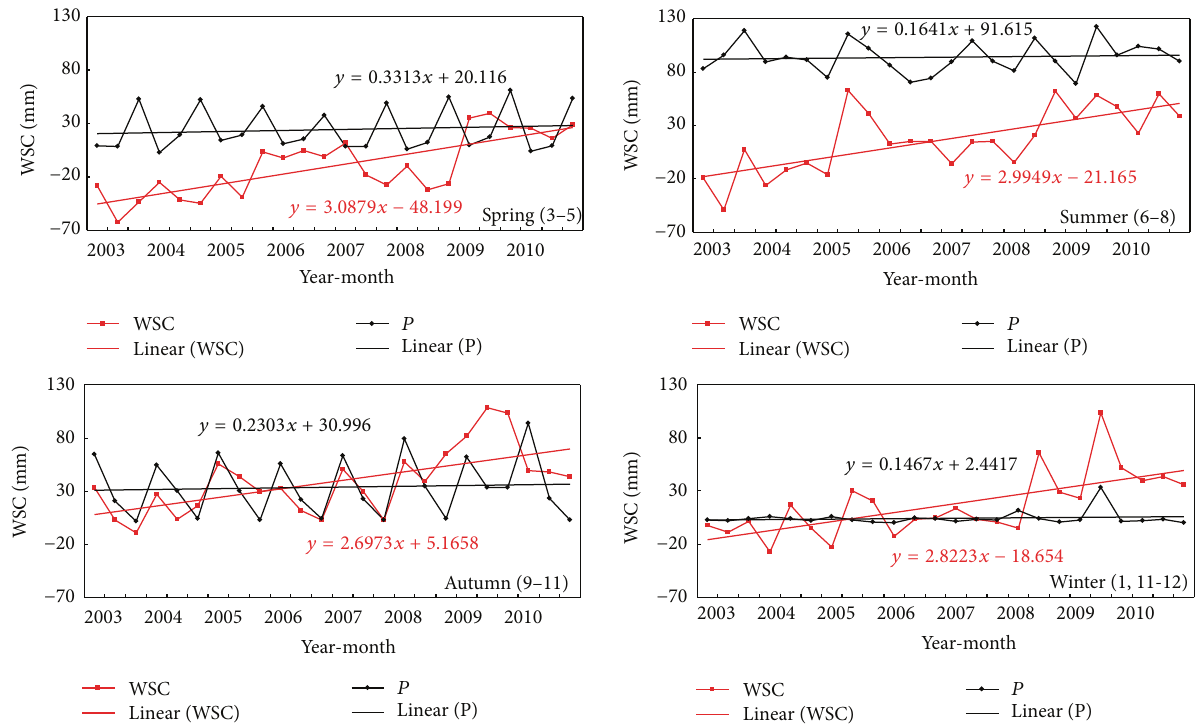
Figure 5: Seasonal processes of water storage change (WSC) and precipitation ( 𝑃 ) in the Three-River Source Region during 2003–2010.